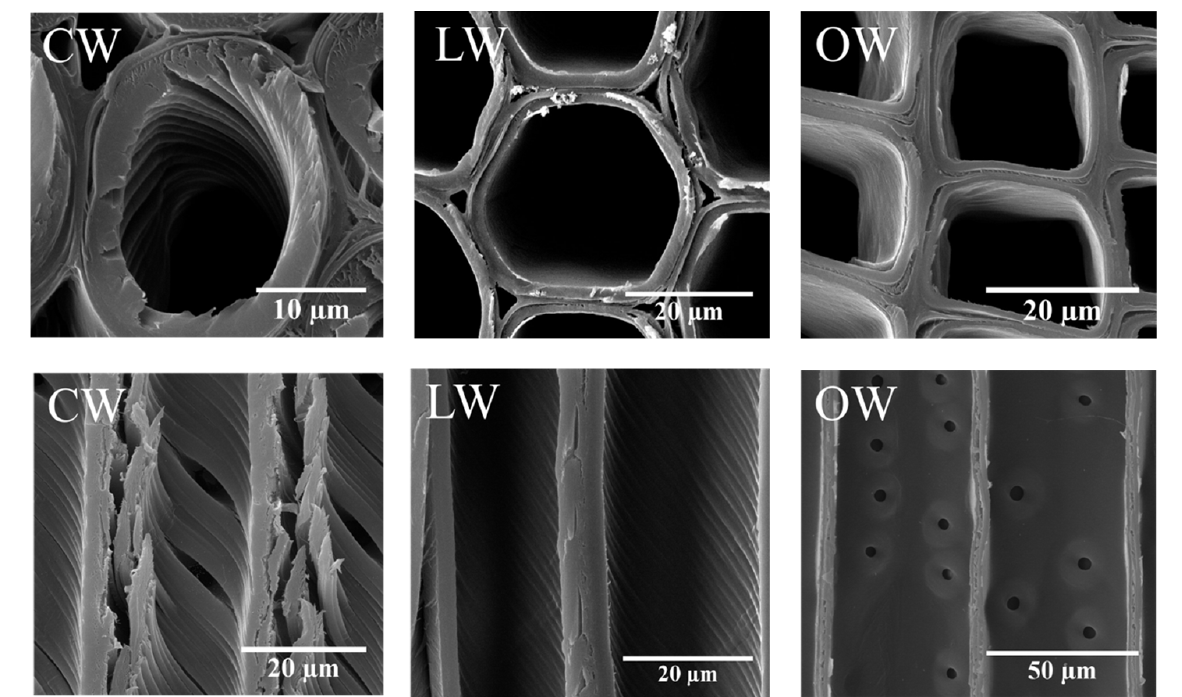
Figure 5. The ultrastructure of CW, LW, and OW tracheids of T . Zhongshanshan.